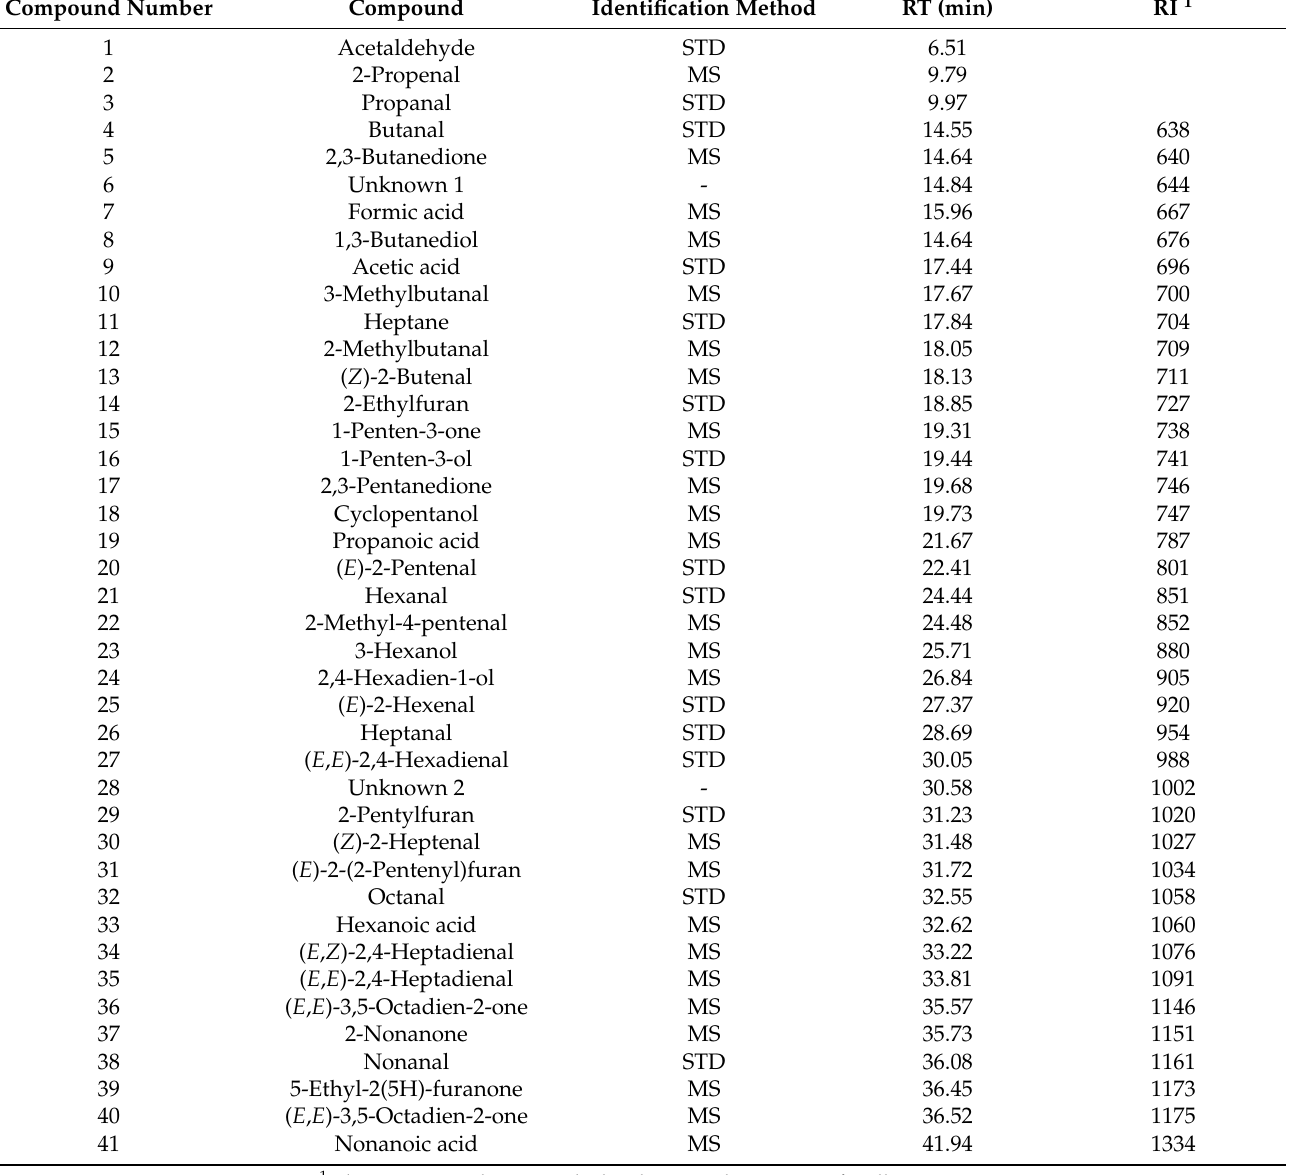
Table 5. All identified volatile compounds of enzymatically extracted Baltic herring oil. The compounds were identified based on the literature, NIST library and external standards (STD). Retention indices for HS-SPME-GC-MS of some volatile compounds are also presented. The column was SPB ® -624 Fused Silica Capillary Column 60 m × 0.25 mm × 1.4 µ